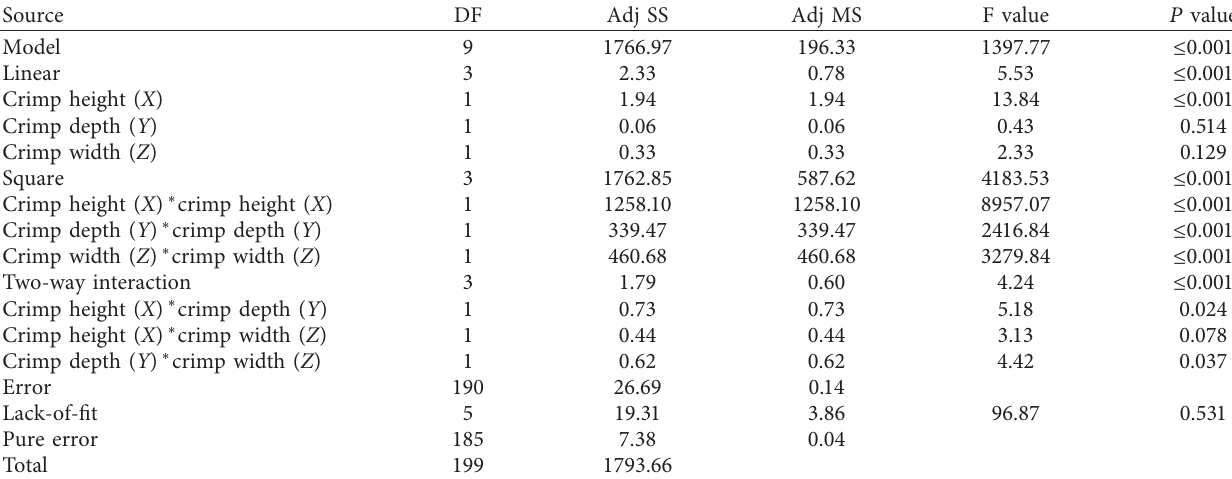
Table 3: Analysis of variance.